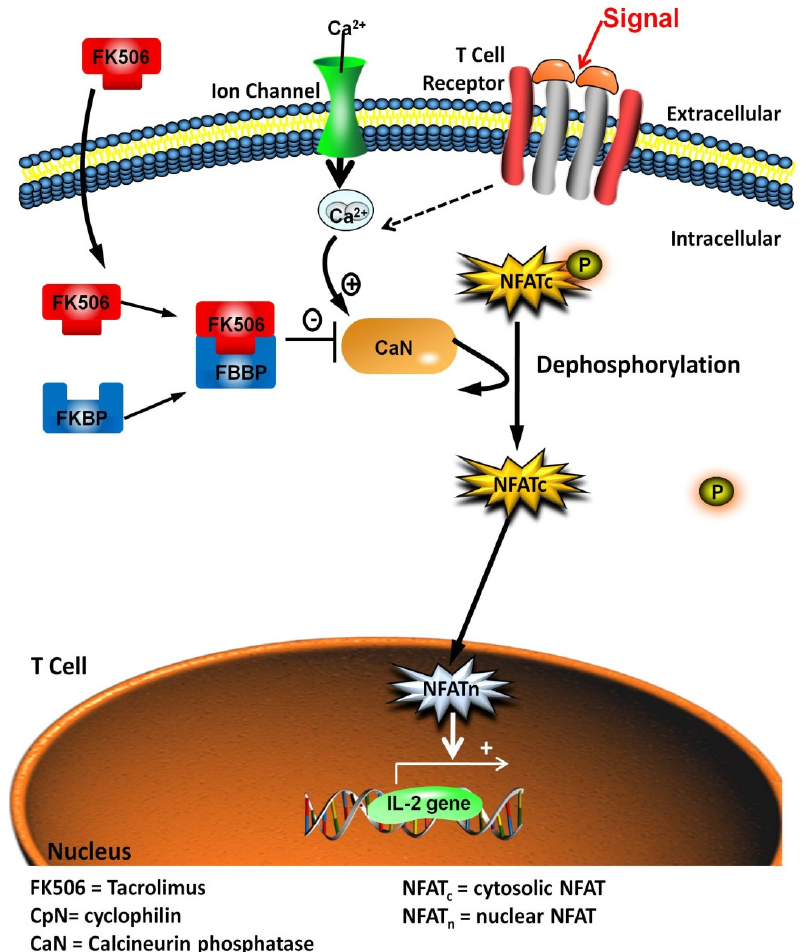
Figure 1. Mechanism of action of tacrolimus (FK506). In the cytoplasm tacrolimus (FK506) binds to